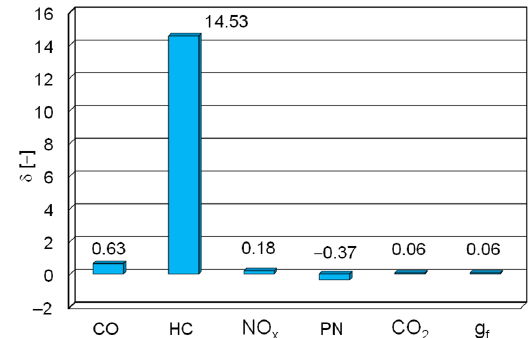
Figure 16. The relative change ( δ ) of the measured road emissions, the road number of particles emitted, and the road fuel mass consumption in the NEDC test for a hot engine start in relation to those values for a cold engine start.